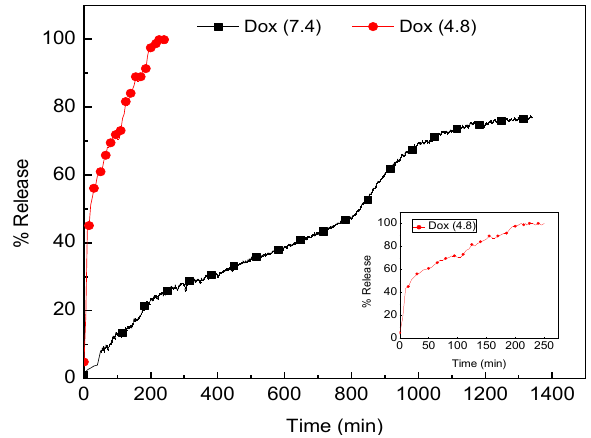
Figure 4. Doxorubicin Release Profiles in PBS, pH 4.8 and